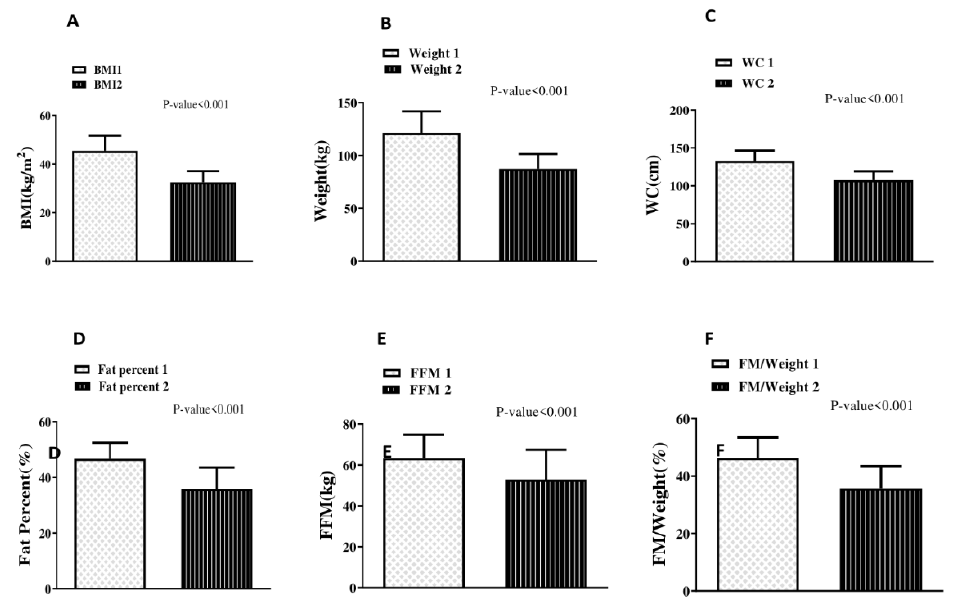
Figure 1. Anthropometric indices before and after bariatric surgery. BMI: body mass index; FFM: fat free mass; FM: fat mass; WC: waist circumference.